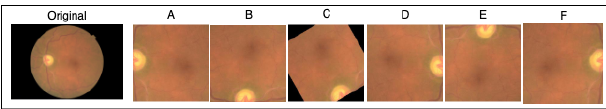
Figure 4. Examples of augmentation performed in Mild DR fundus images; Original; (A) Crop; (B) Rotate 90 °; (C) Rotate 120 °; (D) Rotate 180 °; (E) Rotate 270 °; (F) Mirror